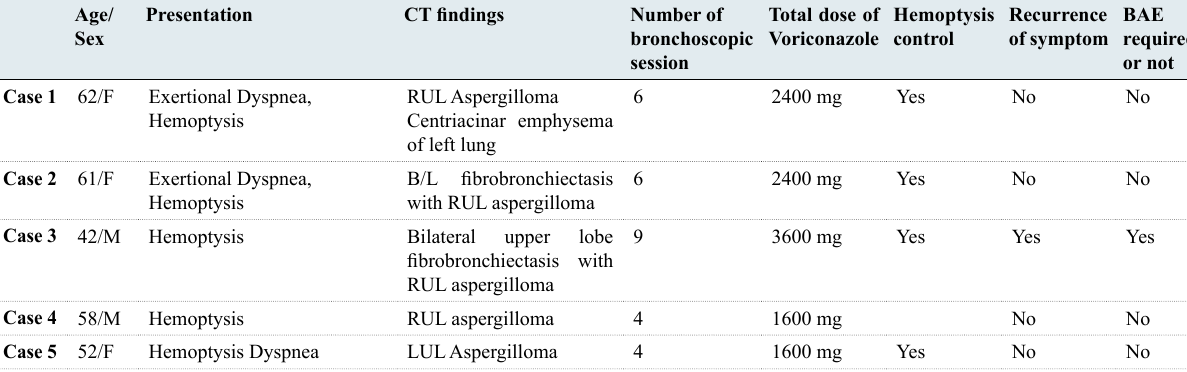
Table 1: Clinical, radiological and bronchoscopic details along with the outcome of patients included in the study Age/